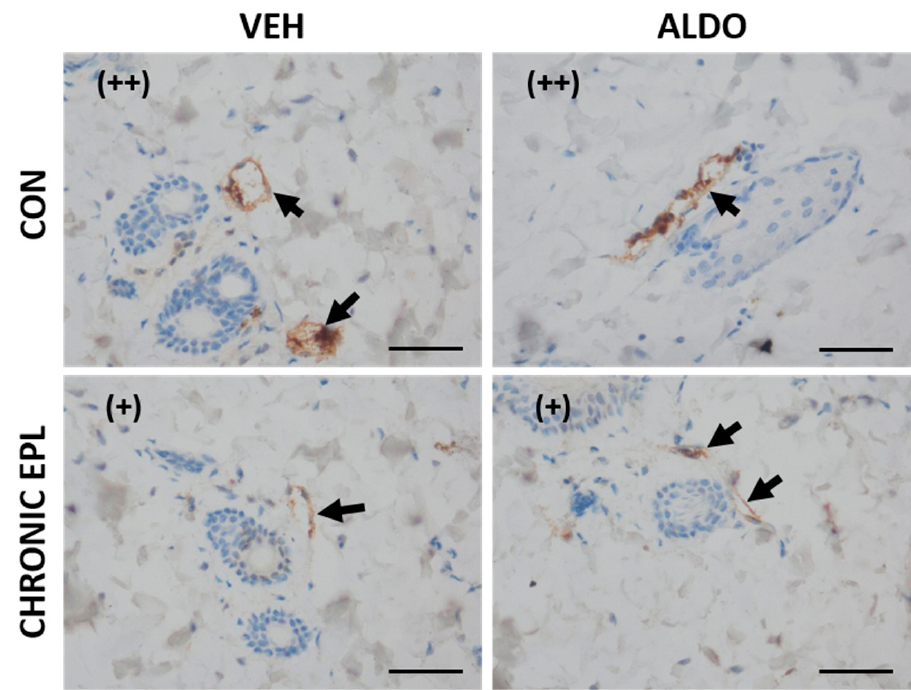
Figure 7. Chronic EPL administration led to VEGF staining reduction in the skin vasculature. n = 8; n for each group is the number of skin samples, not the number of animals; 32 rats were used in this experiment; immunohistochemical staining for VEGF was not changed in ALDO-injected skin (++). Chronic EPL administration decreased signal strength (+). ALDO—aldosterone; CON—5% gum arabic solution; EPL—eplerenone; VEH—ALDO solvent. (+)—slight staining; (++)—moderate staining. Arrows point to blood vessels. Scale bars: 50 µ m.